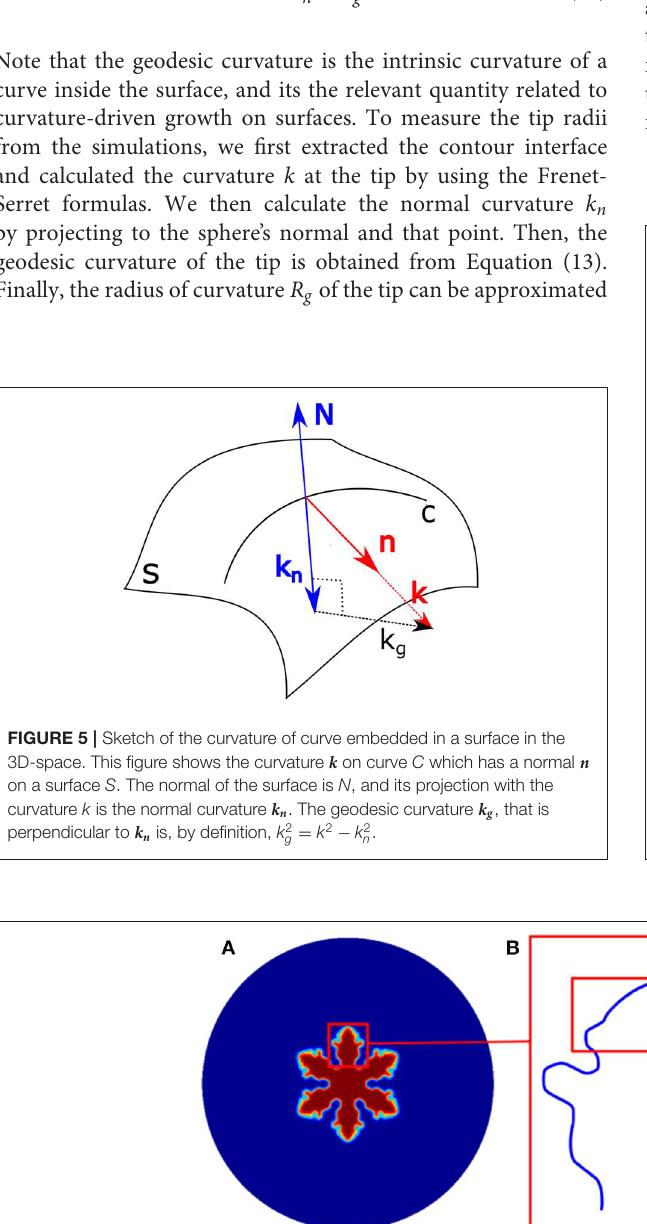
FIGURE 6 | Dendrite’s tip. (A) Phase-field simulation of a dendrite (sphere of radius 3 and time t